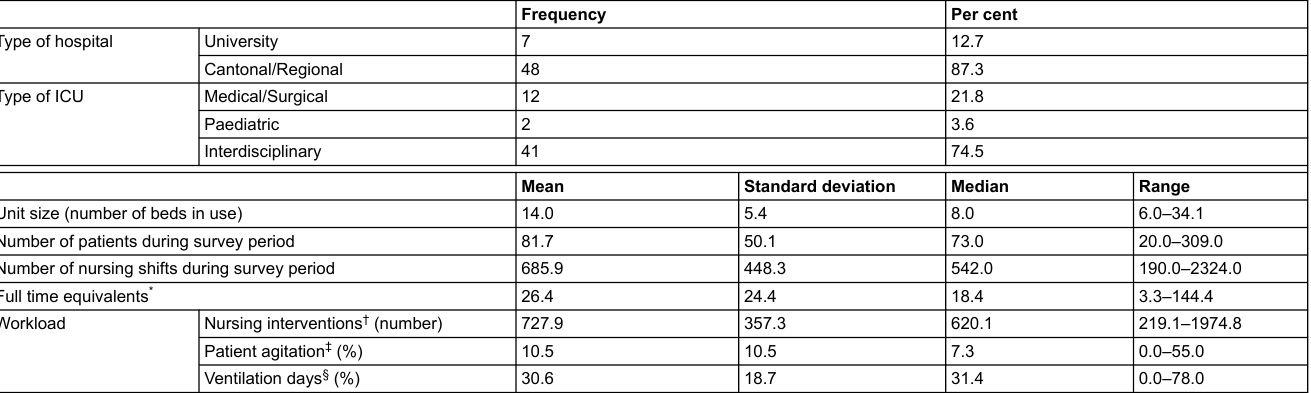
Table 1: Descriptive statistics of intensive care units (n =